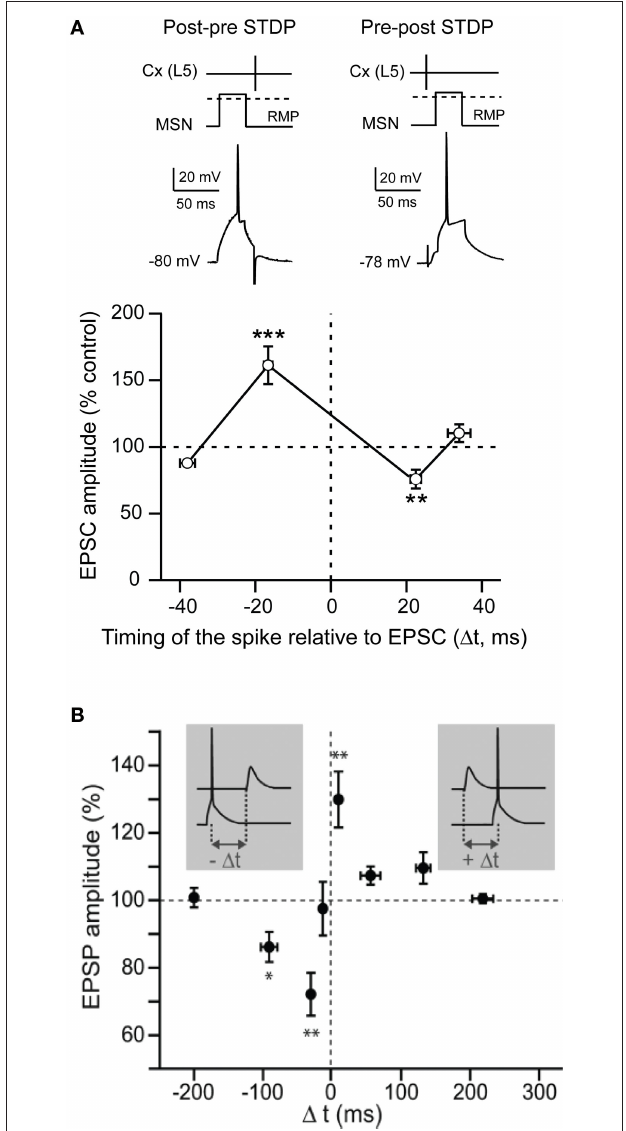
FiGure 3 | Spike-timing dependent plasticity in MSNs. (A) STDP evoked potent bidirectional plasticity at corticostriatal synapses: post-pre pairings (100 paired stimulations at 1 Hz, in native condition) and pre-post pairings induced, respectively, t-LTP and t-LTD (Adapted from Fino et al., 2005). (B) STDP (60 paired stimulations at 0.1 Hz, in picrotoxine condition): post-pre and pre-post pairings induced, respectively, a t-LTD and a t-LTP (Adapted from Pawlak and Kerr, 2008). In conclusion, although the spike-timing dependence appears to be highly dependent on the experimental conditions, it highlights the wide potentiality of the corticostriatal